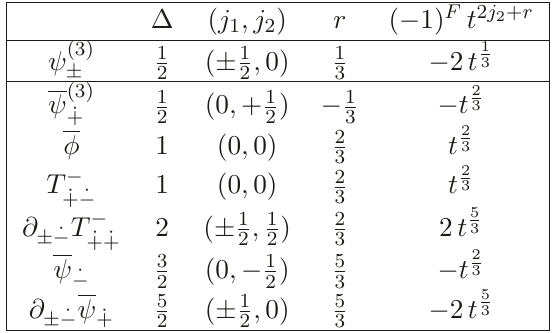
Table 4 . Contributions to the index of the [ 1 tensor are symmetric in the (dotted) undotted indices.